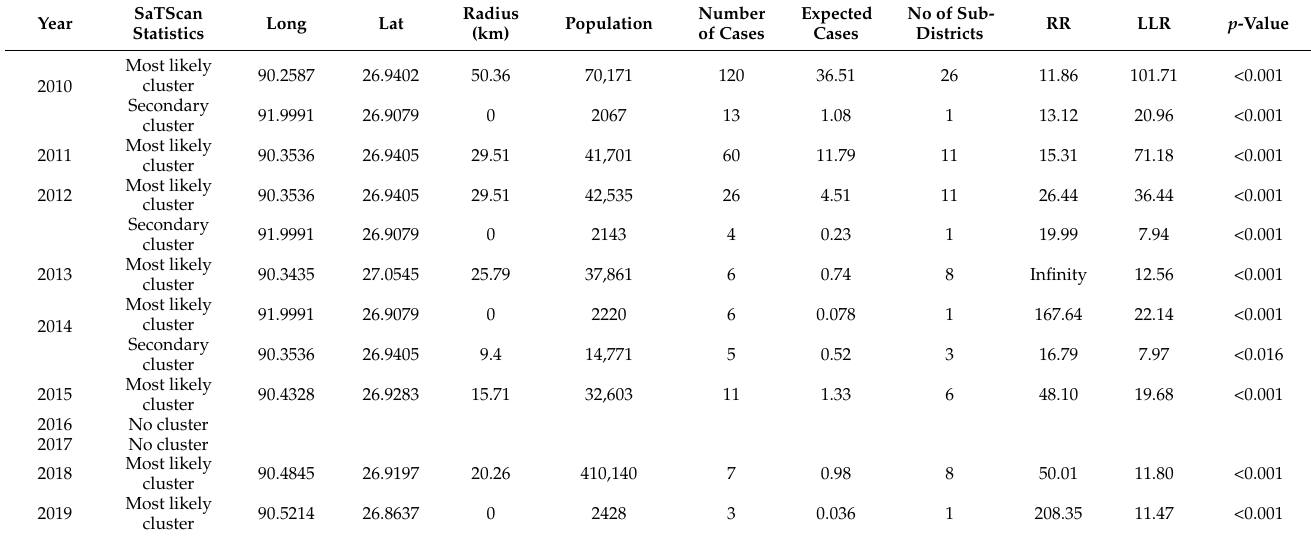
Table 2. Spatial clusters of Plasmodium falciparum in Bhutan, 2010 – 2019.